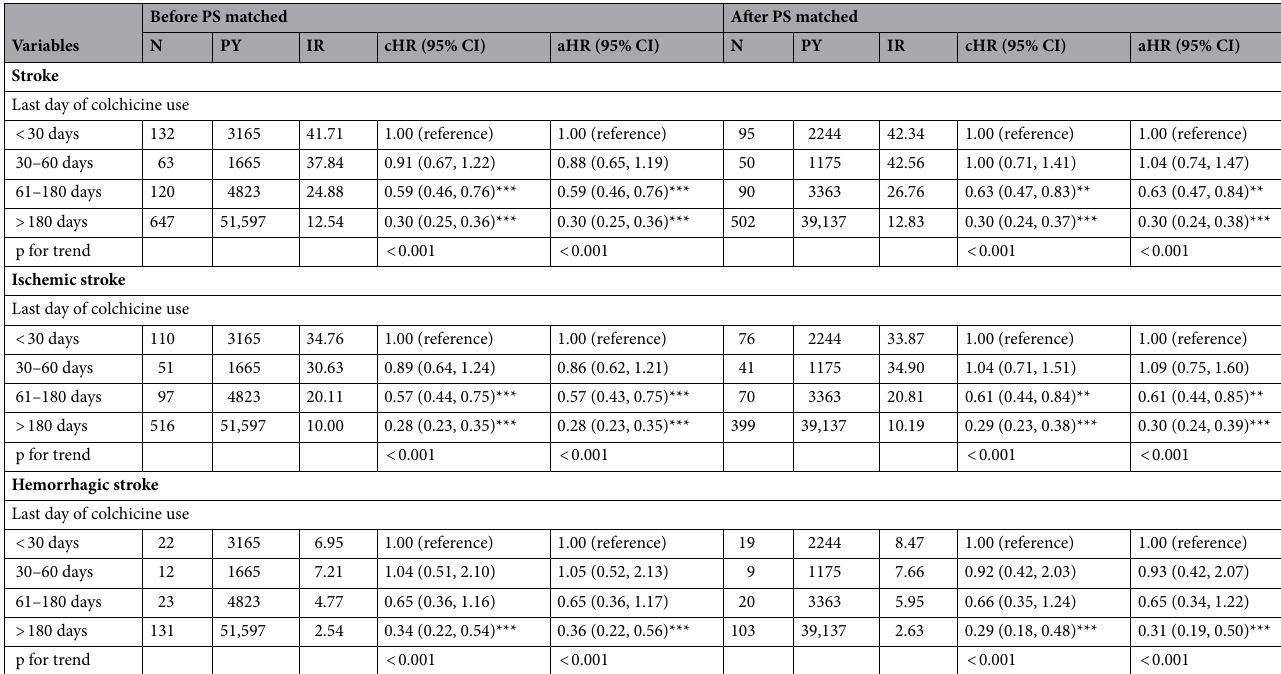
Table 5. Hazard ratio and 95% CI for stroke associated with the last day of colchicine use. aHR adjusted for age, sex, hypertension, hyperlipidemia, hypoglycemia, obesity, gout, pneumonia, hepatitis B, hepatitis C, liver cirrhosis, Allopurinol, Benzbromarone, nsaid, Oralsteroid, Antithrombotic, adapted Diabetes Complications Severity Index, aDCSI and inpatient day. PS, propensity score; N, number of event; PY, person-years;